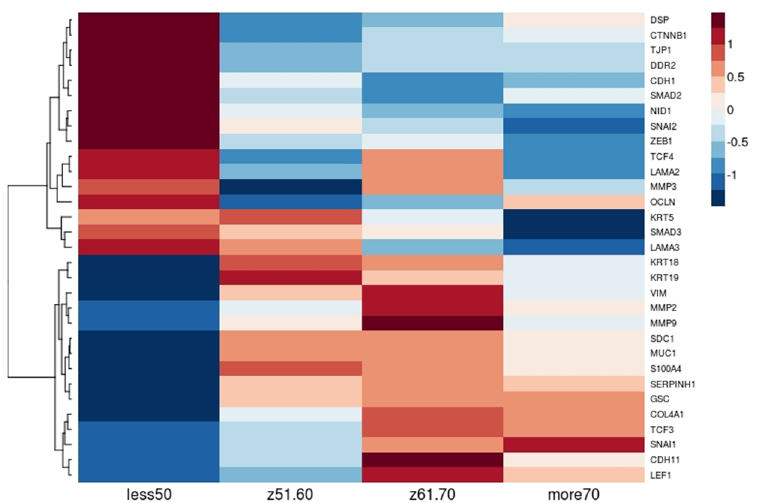
Fig 3. Characteristics of PRAD patients are related to different EMT profile in association with patient’s age. The oppositeprofilesof expressionof particularEMT markers in the youngestvs the oldest patientshave beenidentified:heightenedexpression of CDH1 and CTNNB1 in patientsbelow50 years old and elevated expressionof SNAI1 and simultaneous loweredexpressionof CDH1 and CTNBB1 in older patients.